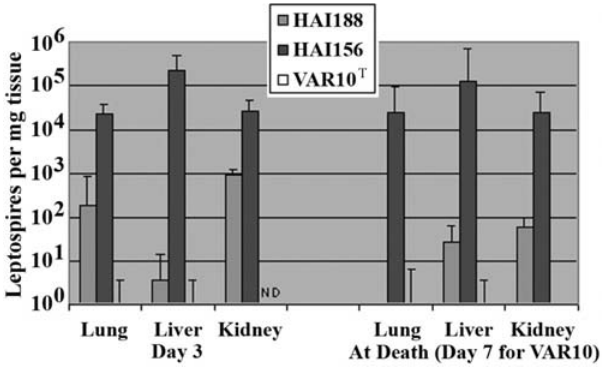
Figure 5. Real time quantitative PCR analysis of experimental leptospiral infections of hamsters. HAI188 and HAI156, strains L. interrogans serogroups Icterohaemorrhagiae and Canicola isolated from patients in Iquitos, Peru. VAR10, ‘‘L. licerasiae’’ serovar Varillal strain VAR 010 T . HAI188 and HAI156 caused a severe moribund state at days 4–5; none of the animals with VAR 010 T exhibited any signs of illness. Three 25 mg samples of each tissue were analyzed and error bars indicate the standard deviations of these three samples per tissue.